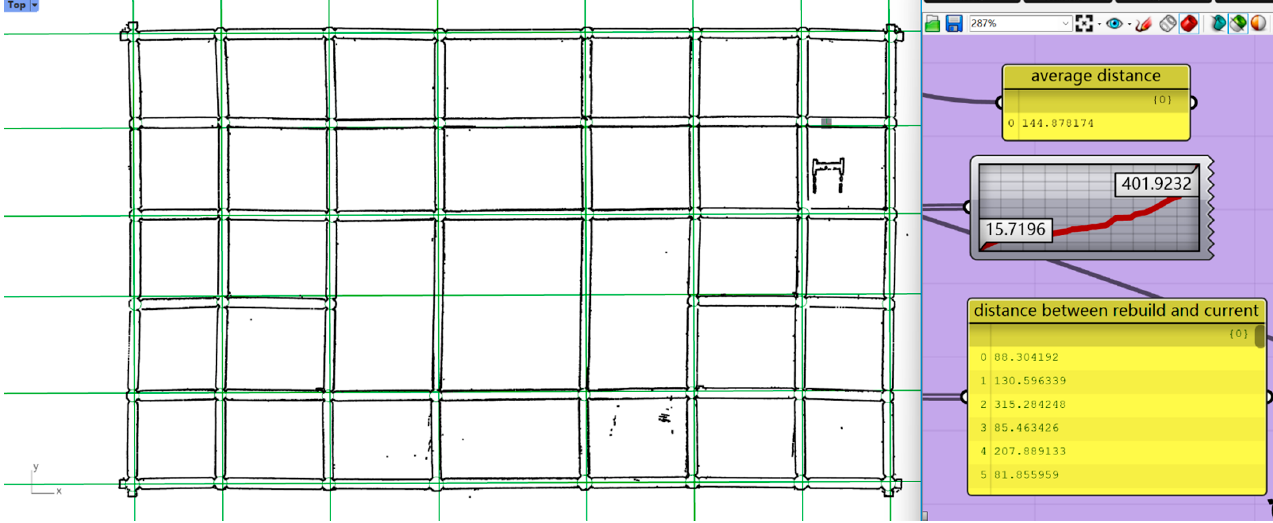
Figure 7. Connect Gauss sum to fitness (blue wire) for genetic algorithm solution.